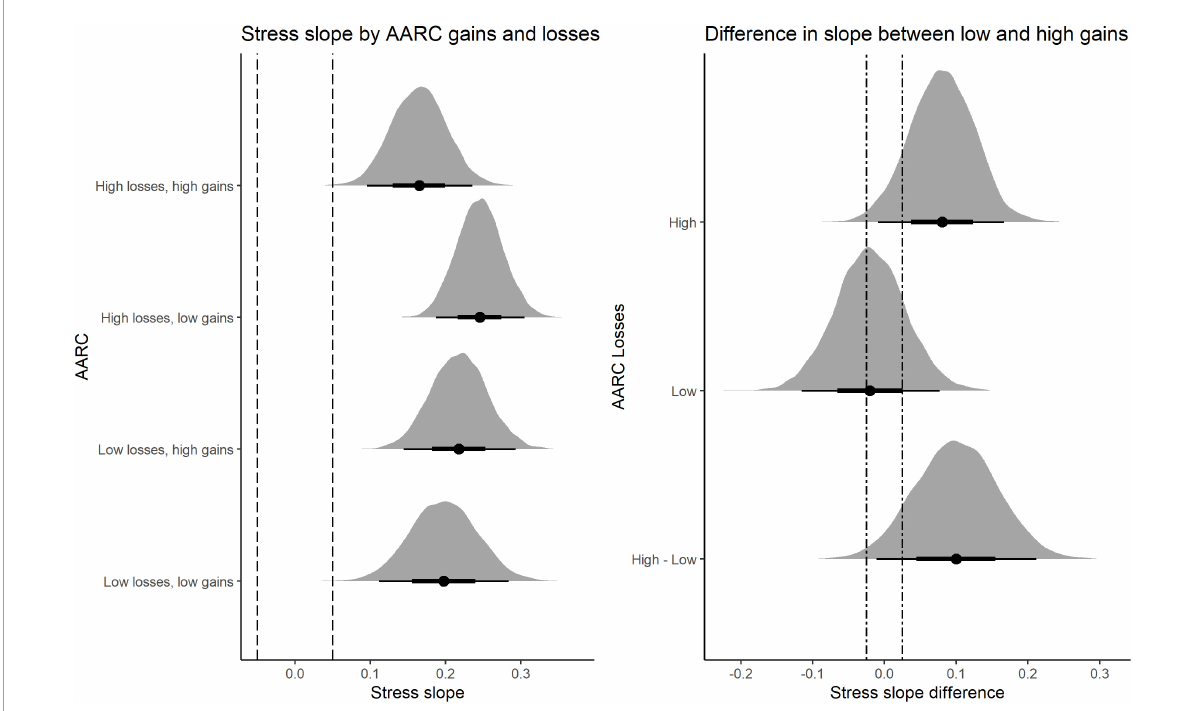
FIGURE2 Left panel shows reactivity slopes (i.e., WP stressor severity) for combinations of lower ( − 1 SD ) and higher (+ 1 SD ) WP AARC-gains and WP AARC-losses. Right panel shows the difference between reactivity slopes for lower and higher WP AARC-losses, separately for lower and higher WP AARC-gains as well as higher minus lower AARC-gains. The latter value reflects the effect size of the 3-way interaction. The dashed lines represent the ROPE 0 . 05 and the dot-dash line indicates the ROPE 0 . 025